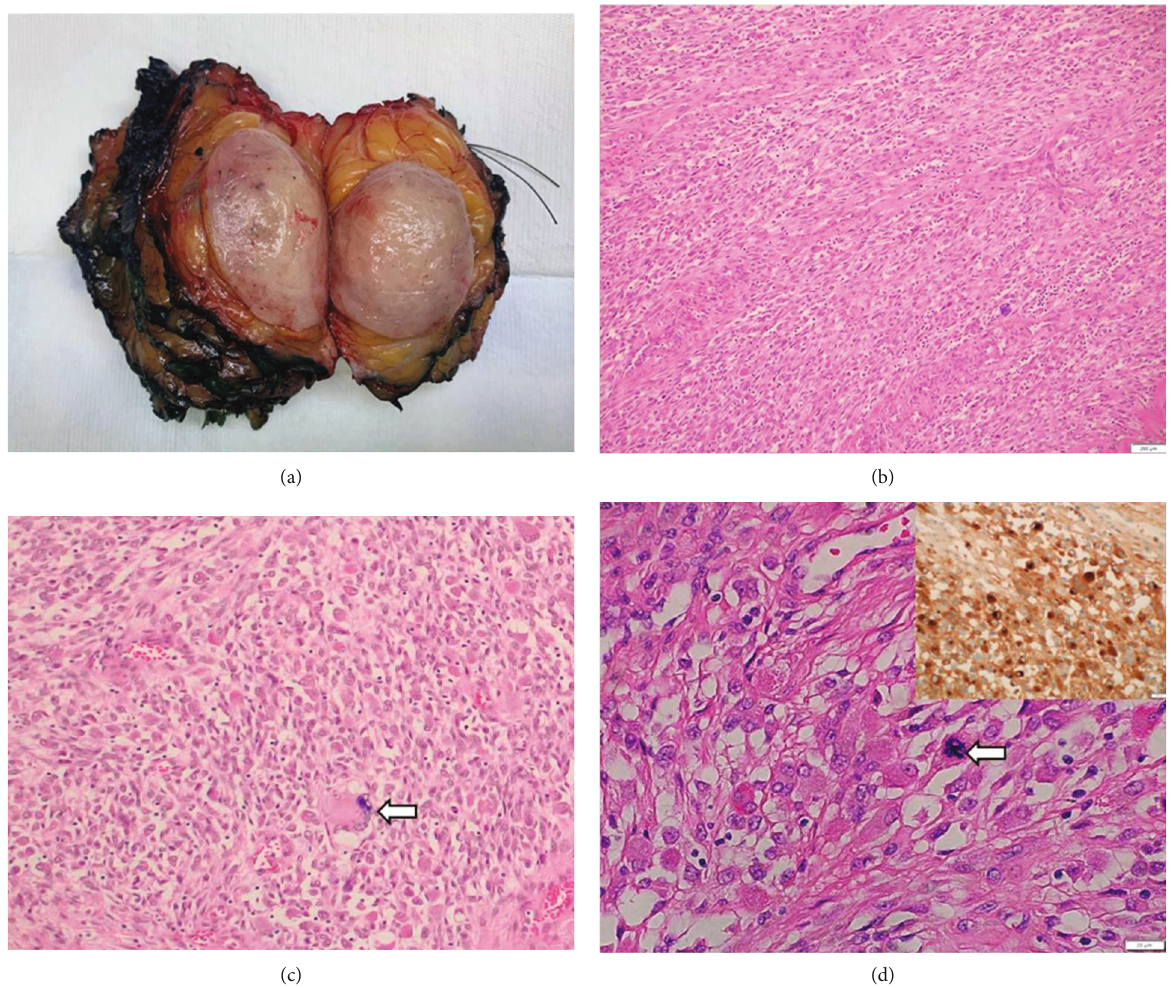
Figure 2: The tumor grossly shows fl eshy gray cut surface with well-circumscribed round edges (a). Histological examination shows nested pseudoalveolar proliferation of histiocytes and synoviocytes showing abundant eosinophilic cytoplasm with some perinuclear hemosiderin (H&E, (b) -100x and (c) -200x). Scattered multinucleated osteoclast-like giant cells are seen (H&E (c) -200x, arrow). The tumor shows atypical cytological features in the form of atypical mitotic fi gures (H&E (d) -400x, arrow). The neoplastic cells are di ff usely positive for immunohistochemical stain for clusterin antibody (clusterin IHC, (e) -upper right